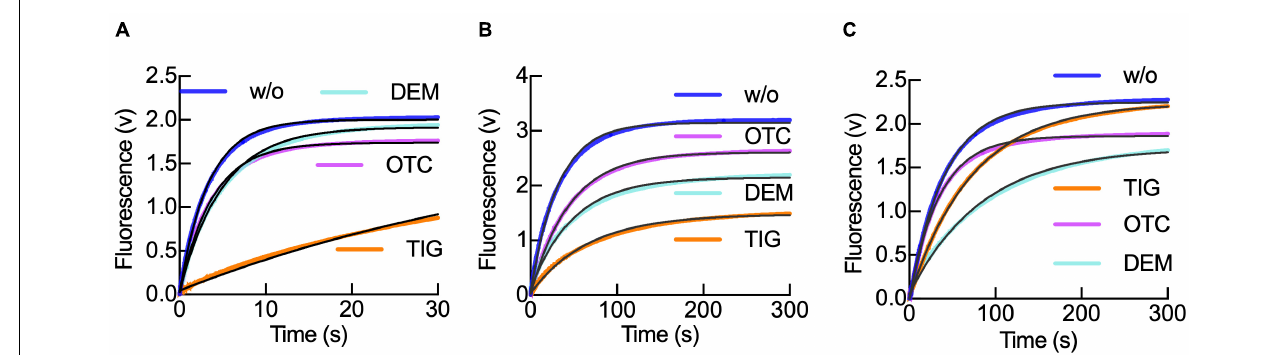
FIGURE 3 | Tetracyclines modulate IF1 retention in the 30S subunit during translation initiation progression. (A) Time courses of IF1 540Q dissociation from 0.05 µ M 30S–IF3 488 –IF1 540Q complexes upon mixing with 0.5 µ M of unlabeled IF1 in the absence (blue) or in the presence of either Otc (pink), Dem (aquamarine), or Tig (orange). (B) As panel (A) for 0.05 µ M 30S pre-initiation complexes (30S pre-IC) using the same FRET pair and in the presence of 0.15 µ M IF2, 0.3 µ M mRNA, and 0.2 mM GTP. (C) As panel (B) for the 30S IC formed by the addition of 0.15 µ M fMet-tRNA fMet followed by 30 min incubation at 37 ◦ C. Shown time courses result from six to eight averaged replicates. Continuous black lines represent the non-linear fitting with a single exponential term (Eq. 1) for a single-step model of IF1 interaction with the 30S subunit (Milon et al., 2012). The resultant dissociation rate constants k − 1 are shown in Table 2 .